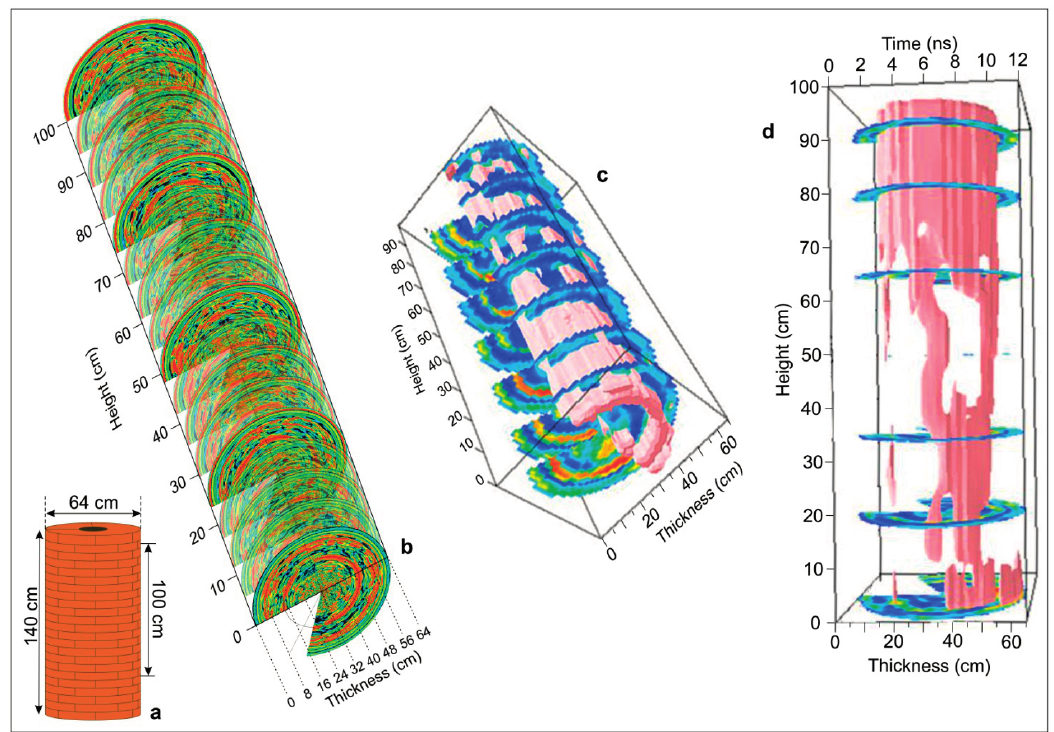
Figure 8. Three-dimensional images of the column. ( a ) Scheme of the tested specimen. One hundred meters were tested by means of circular GPR profiles. ( b ) The 3D composition of some circular radargrams. ( c ) The isosurface render generated with GPRSlice software, showing the anomaly that probably corresponds to the inner pipe and other smaller targets. ( d ) Image of the isosurface corresponding to amplitudes higher than 75% of the maximum amplitude. Changes in the amplitude could reveal the existence of possible damages corresponding to void areas in the rendered